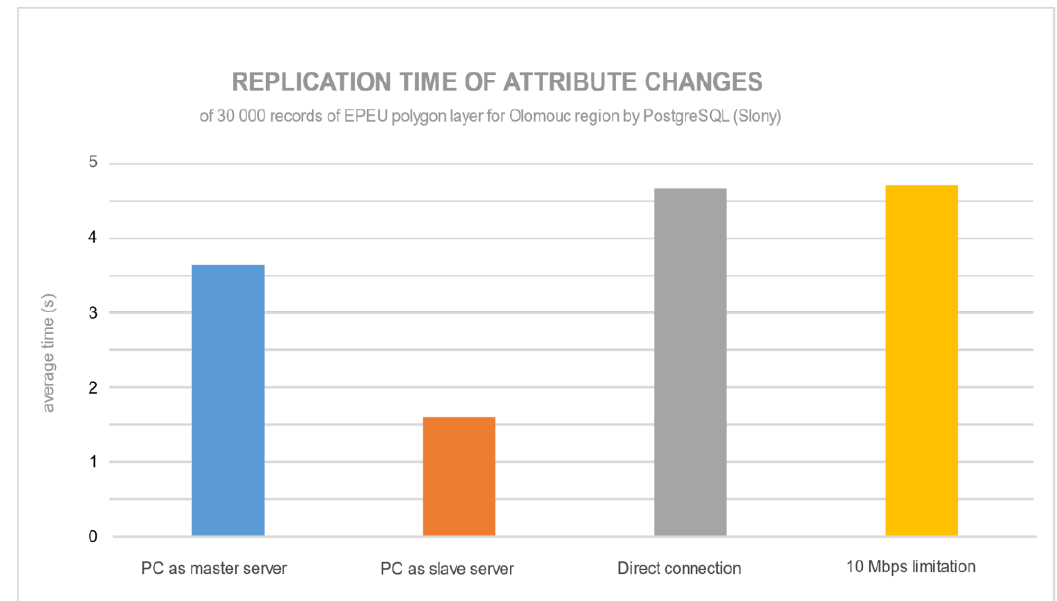
Figure 15. Average replication time of layers with different cluster configurations by PostgreSQL (Slony).